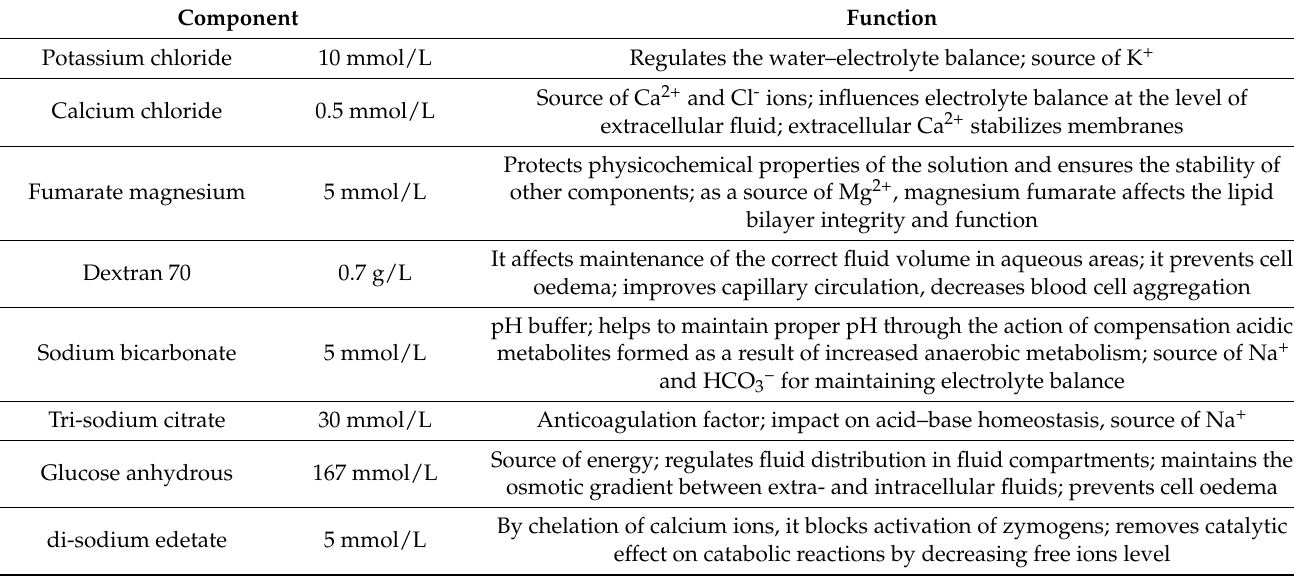
Table 2. The composition of Biolasol